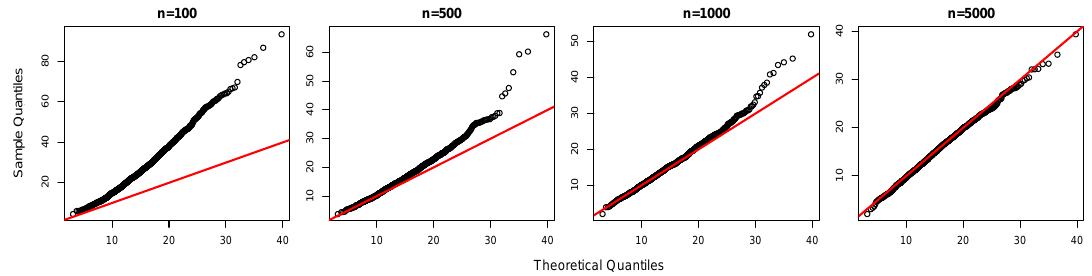
Figure 4: QQ-plots of T n for t -copula with 5 degrees of freedom, d = 6 , τ C = 0.75 and n = 100, 500, 1000 and 5000 .